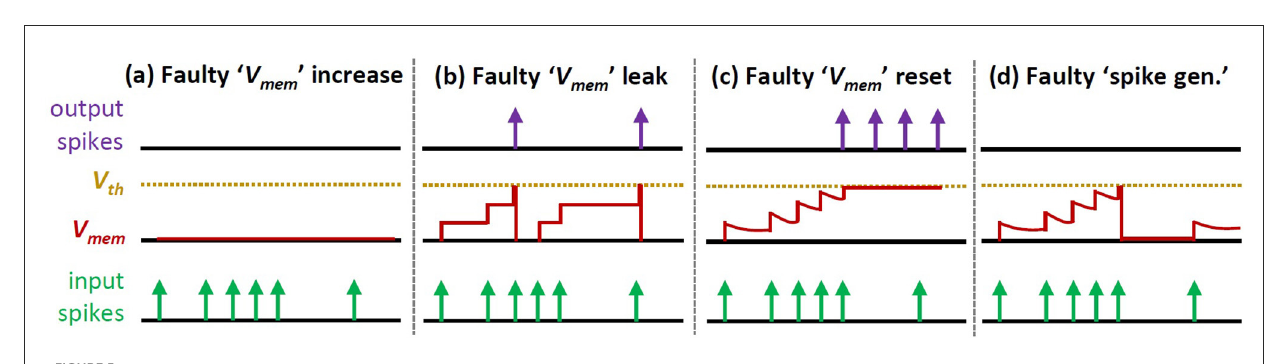
FIGURE5 Overview of different faulty LIF neuron operations: (a) faulty ‘ V mem increase’, (b) faulty ‘ V mem leak’, (c) faulty ‘ V mem reset’, and (d) faulty ‘spike